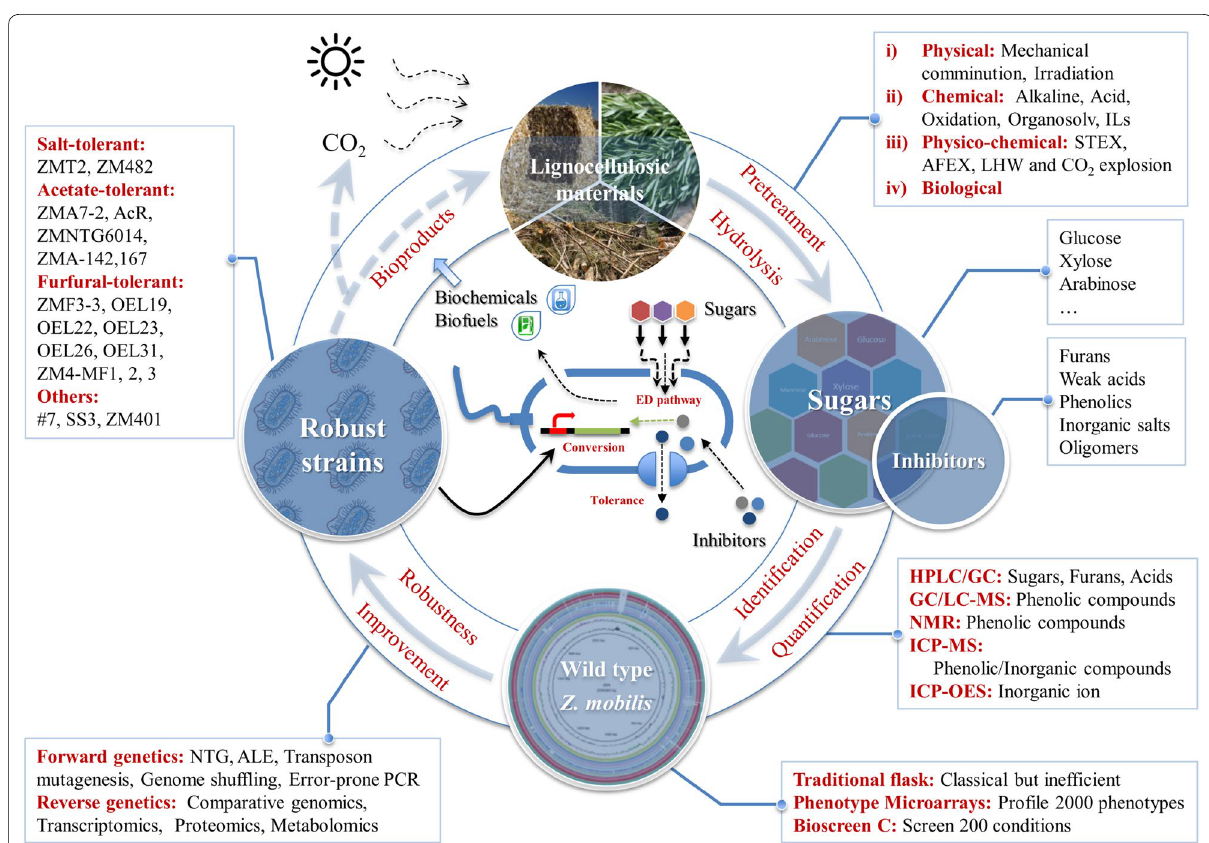
Fig. 1 Overview of the progress on lignocellulosic hydrolysate inhibitor tolerance improvement in Zymomonas mobilis . ILs ionic liquids, STEX steam- ing or steam explosion, AFEX ammonia fiber explosion, LHW liquid hot water, HPLC/GC high-performance liquid chromatography or gas chromatog- raphy, GC/LC–MS gas chromatography or liquid chromatography–mass spectrometer, NMR nuclear magnetic resonance, ICP-MS inductively coupled plasma mass spectrometer, ICP-OES inductively coupled plasma optical emission spectrometry, NTG N -methyl- N ′ -nitro- N -nitrosoguanidine, ALE adaptive laboratory evolution, ED pathway Entner–Doudoroff